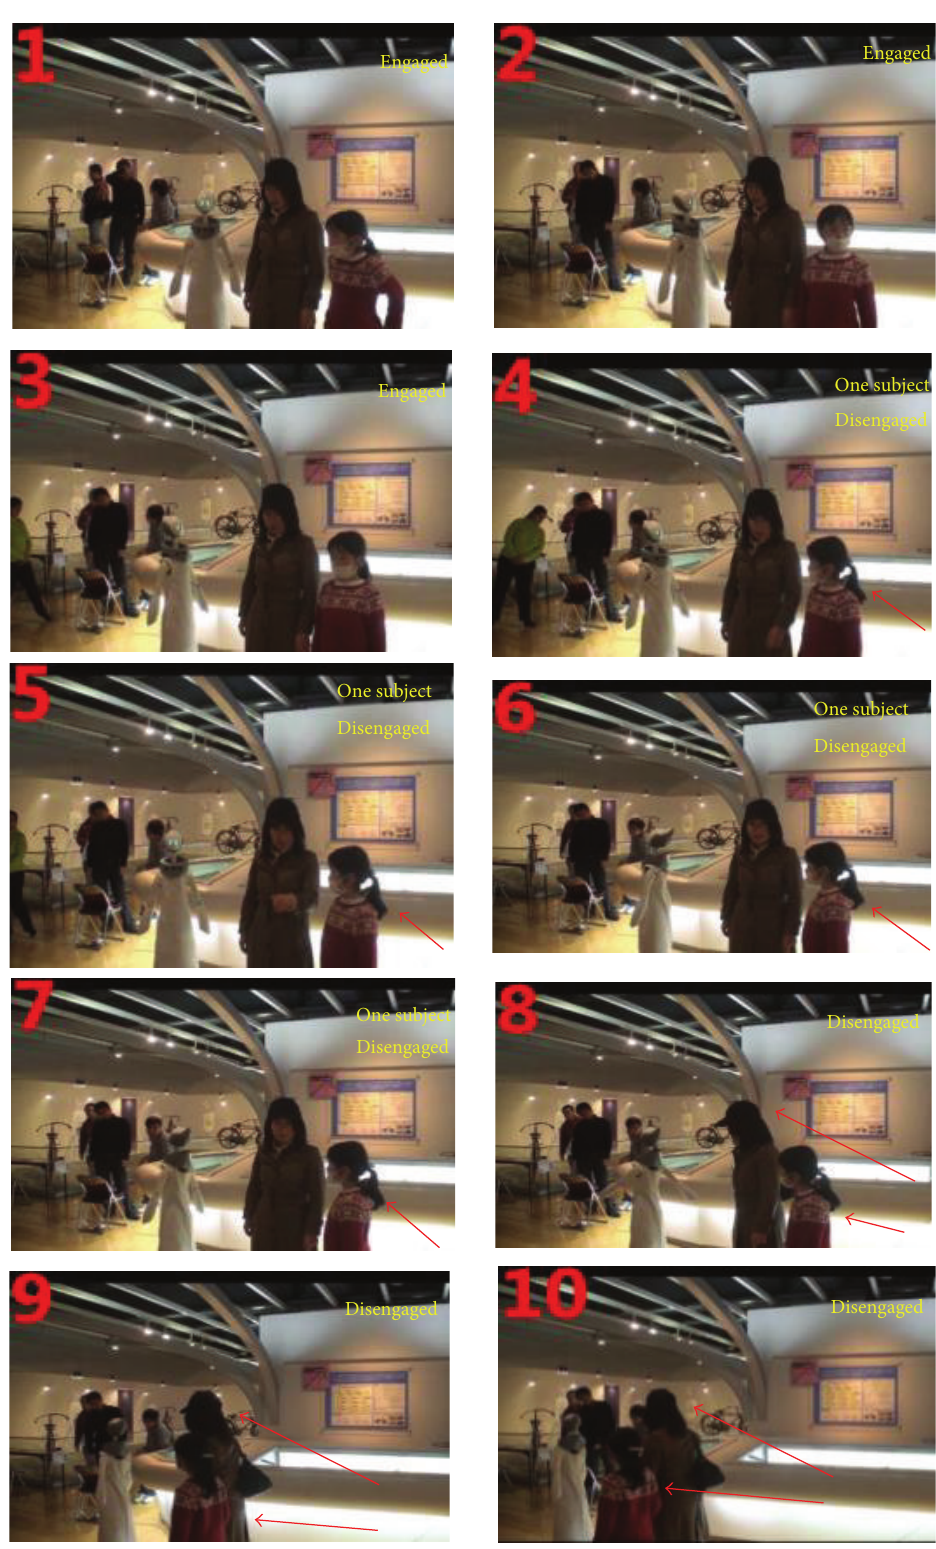
Figure 9: The process of disengagement as seen in sliced